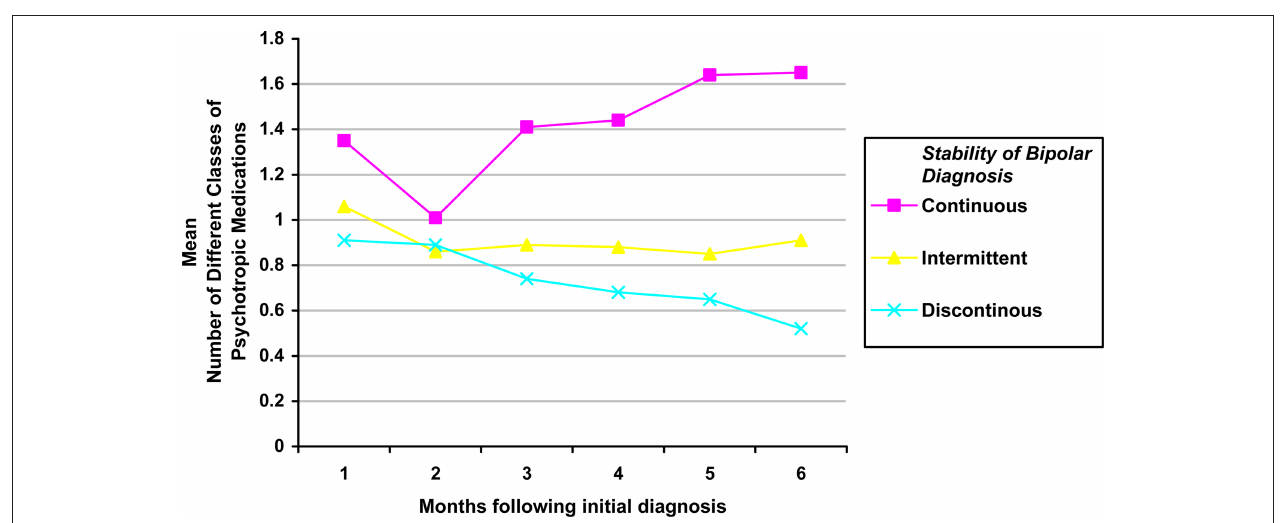
FIgURe 1 | Mean number of classes of psychotropic medication prescriptions filled by stability of bipolar diagnosis by